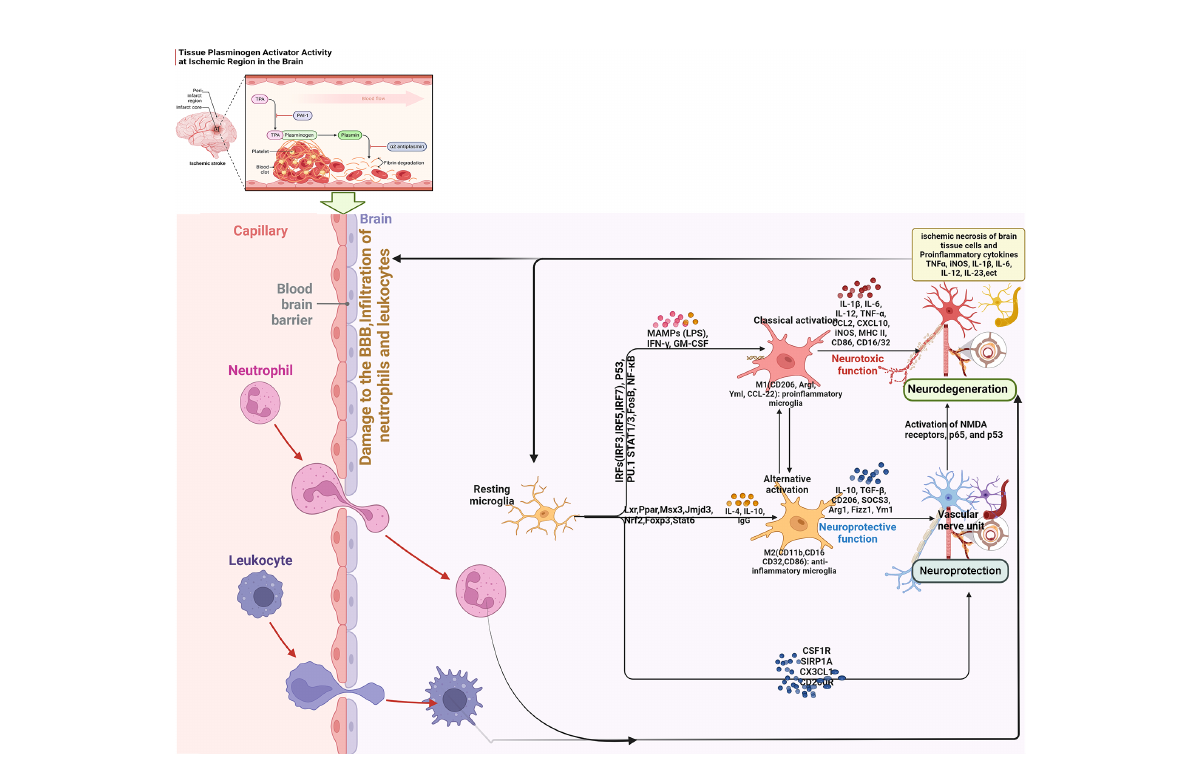
FIGURE 1 Summary of key in fl ammatory responses after ischemic stroke (BBB, blood brain barrier; IRF, interferon regulatory factor; STAT, signal transducer and activator of transcription; NF- k B, nuclear factor- k B; IFN, Interferon; NMDA, N-methyl-D-aspartate receptor; MAMPs, Metabolism-related molecular patterns; LPS, Lipopolysaccharide; GM-CSF, granulocyte-macrophage colony stimulating